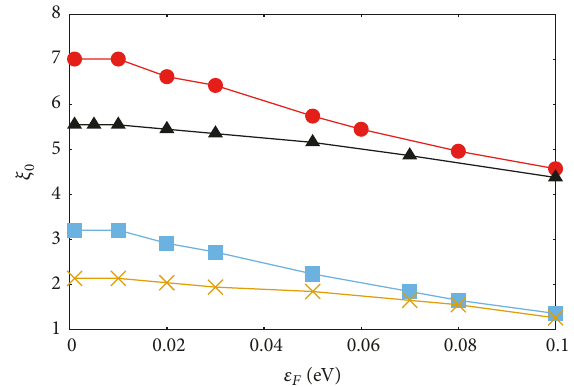
Figure 5: Operating point position relative to the maximum NDC as a function of the Fermi energy for RTD heterostructure number 2 at the following frequencies and temperatures: ℎ𝜔 = 2Γ , 𝑇 = 300 K (orange line); ℎ𝜔 = 2Γ , 𝑇 = 0 K (blue line); ℎ𝜔 = 4Γ , 𝑇 = 300 K (black line); ℎ𝜔 = 4Γ , 𝑇 = 0 K (red line).